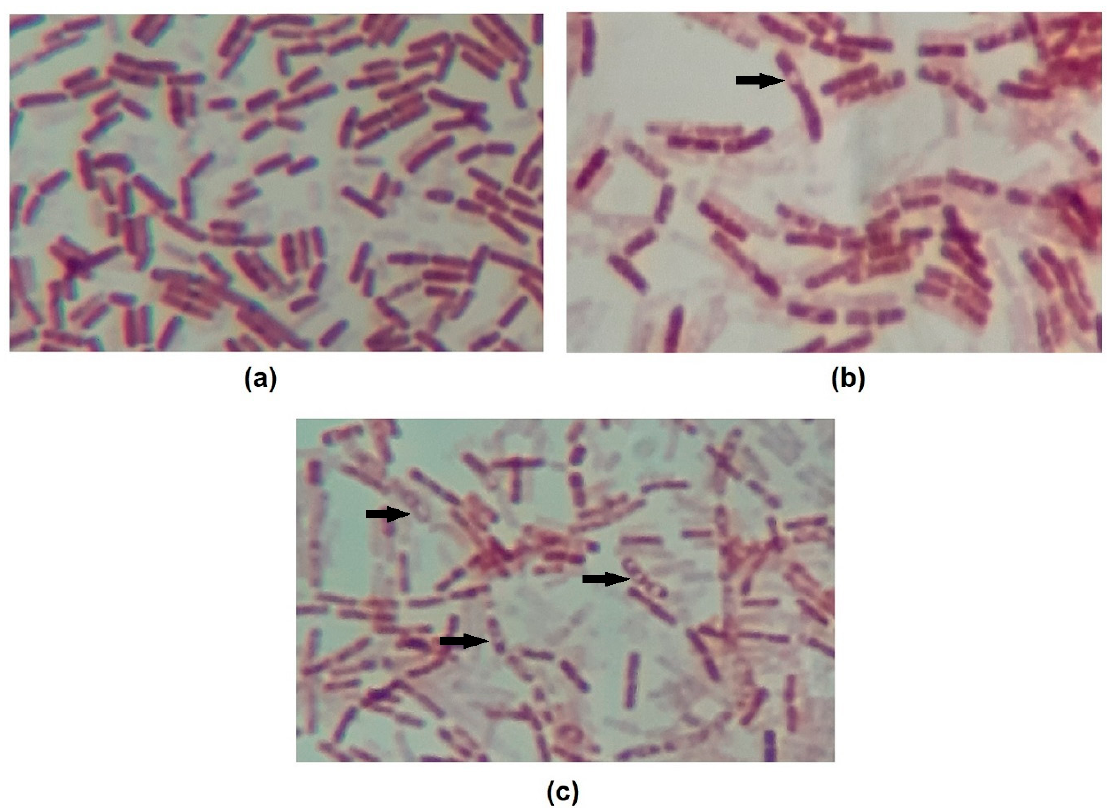
Figure 2. Images of endospore staining of ( a ) control, ( b ) OR + RL MIC 14h and ( c ) OR + RL MIC 24h treatments. Endospores are visible on images ( b ) and ( c ) as an uncolored region inside the cells. Some endospores are indicated by arrows. Magnification 1000×.